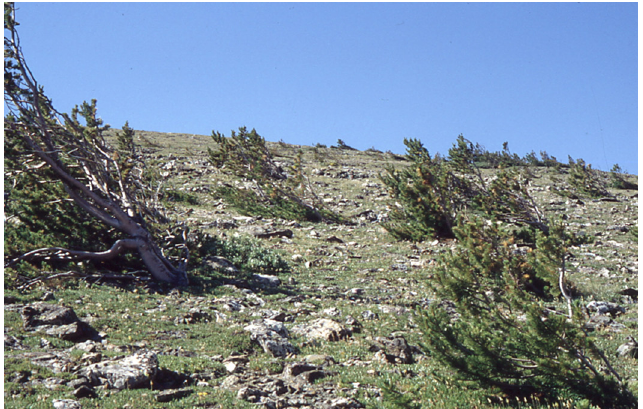
Figure 19: Irregular distribution pattern of limber pines ( Pinus flexilis ) that originated from seed caches of the Clark´s nutcracker ( Caryocatactes columbiana ) on relatively uniform terrain of Bald Mountain (Colorado Front Range) at about 3420 m. Photo taken by the author, 15 July 1994. During extensive fieldwork on treeline in the Alps, the author observed hundreds of seed caching nutcrackers.